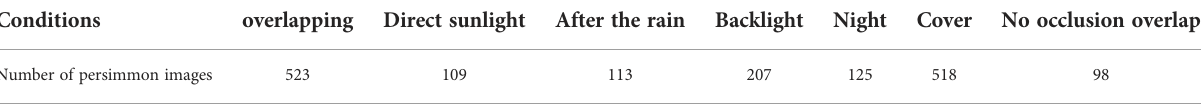
TABLE 1 Sample distribution details of green fruit images (The following table lists the number of persimmons in the dataset under different scenarios). Conditions